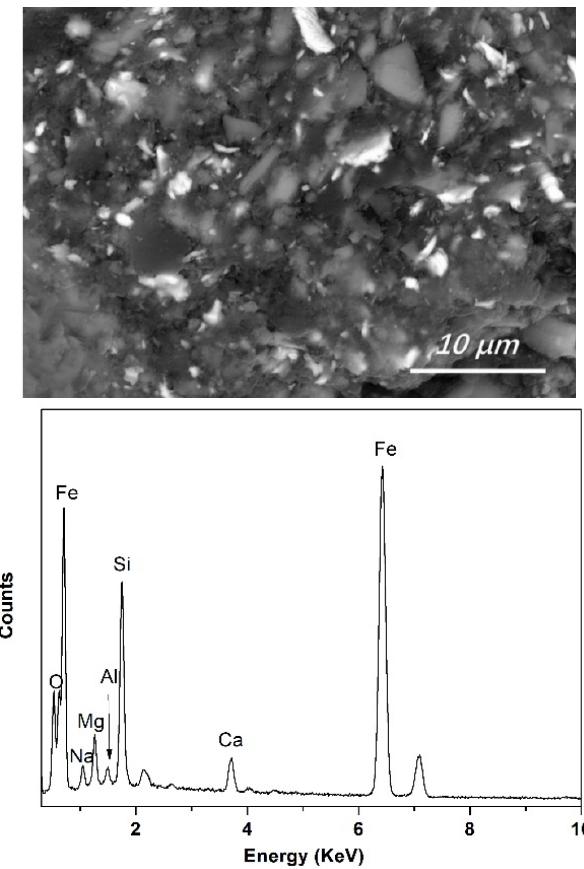
Figure 8. Typical morphology of Fe-concentrated phase in final slag and EDS analysis of the bright Fe-concentrated phase (backscattered electron image, No. 1 slag, sample cooling in furnace).